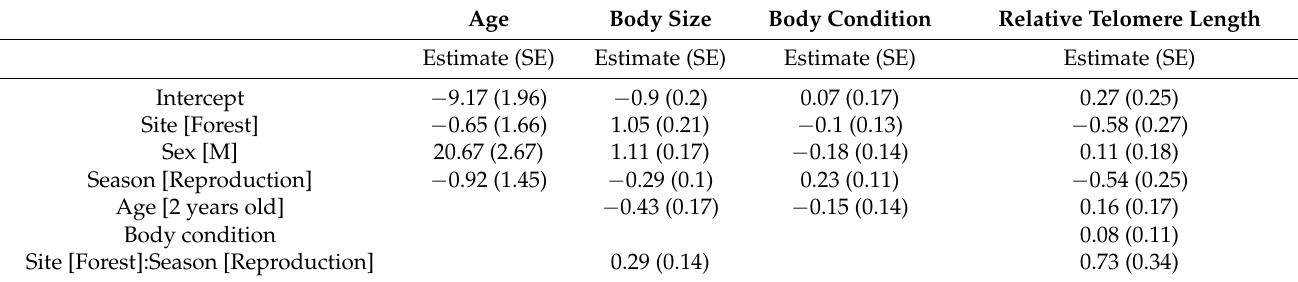
Table A4. Difference of quality parameters between seasons for each site.